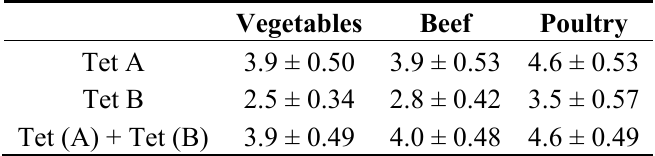
Table 3. Mean counts of bacteria harboring the tet (A) and/or the tet (B) genes in baby foods for infants and young children based of poultry meat, beef and